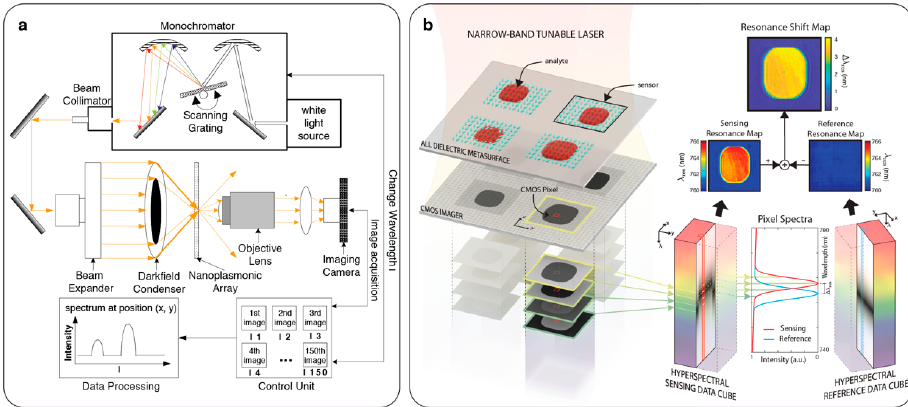
Figure 4. Hyperspectral imaging-based two-dimensional (2D) spatial optical interrogation of nanophotonic sensors. ( a ) Dark-field transmission configuration used to acquire scattering spectra from many individual plasmonic nanoparticles simultaneously. Adapted with permission from [71]. Copyright 2005 American Chemical Society; ( b ) bright-field transmission configuration used for high throughput spatial and spectral data acquisition from high-Q dielectric metasurfaces. Adapted with permission from [29]. Copyright 2019 Nature Publishing Group.